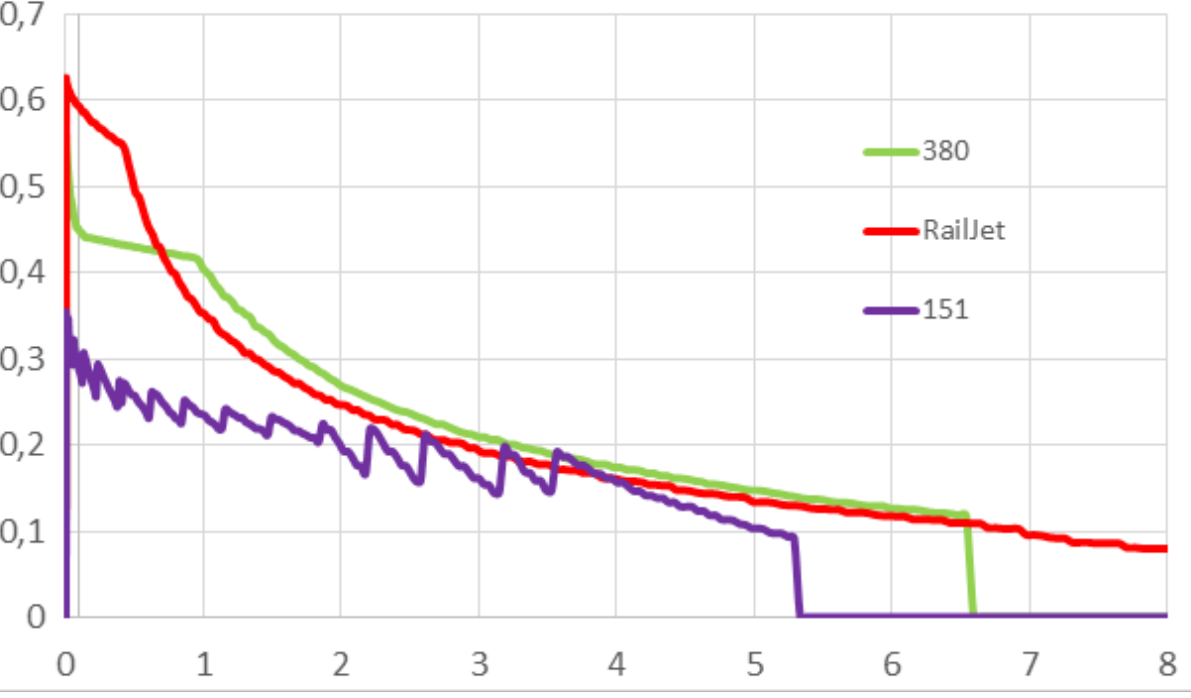
Figure 2. Acceleration of typical trainsets [m · s − 2 ], source: Authors.